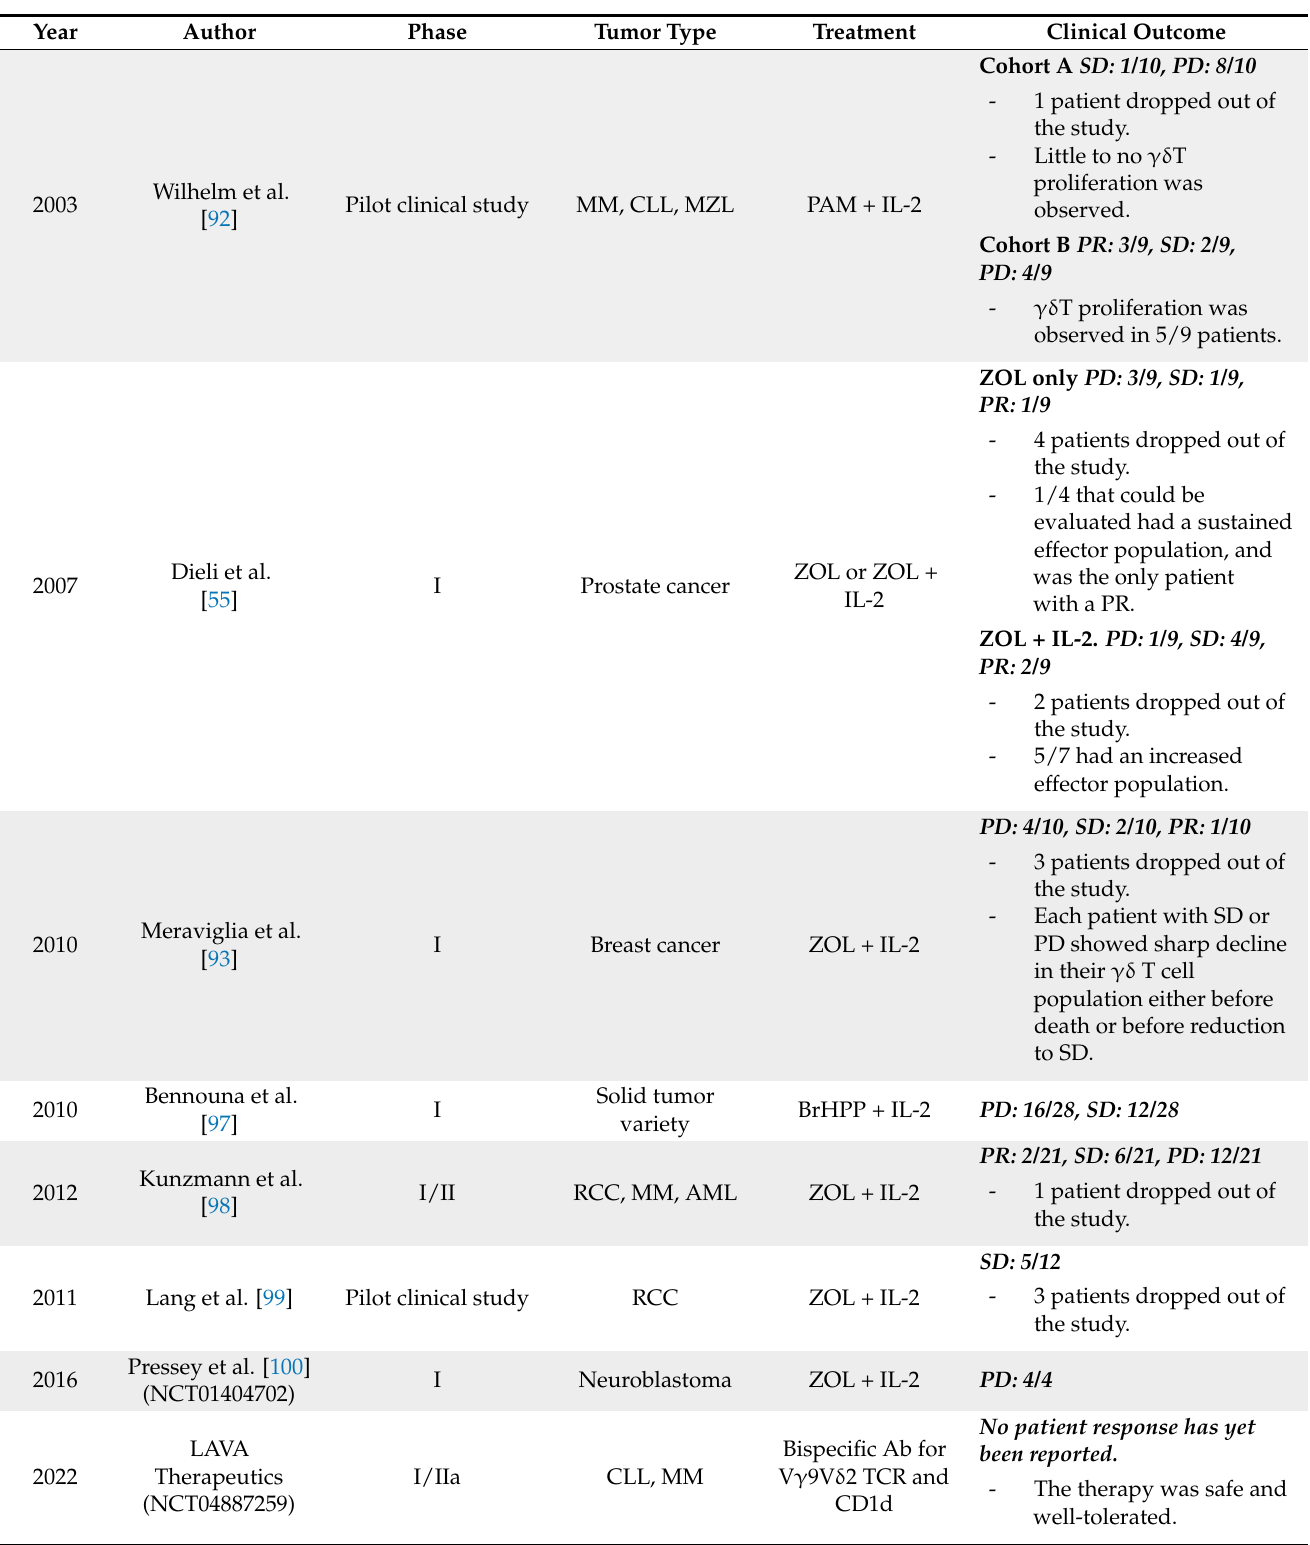
Table 1. Autologous, in vivo expanded γδ T cell clinical